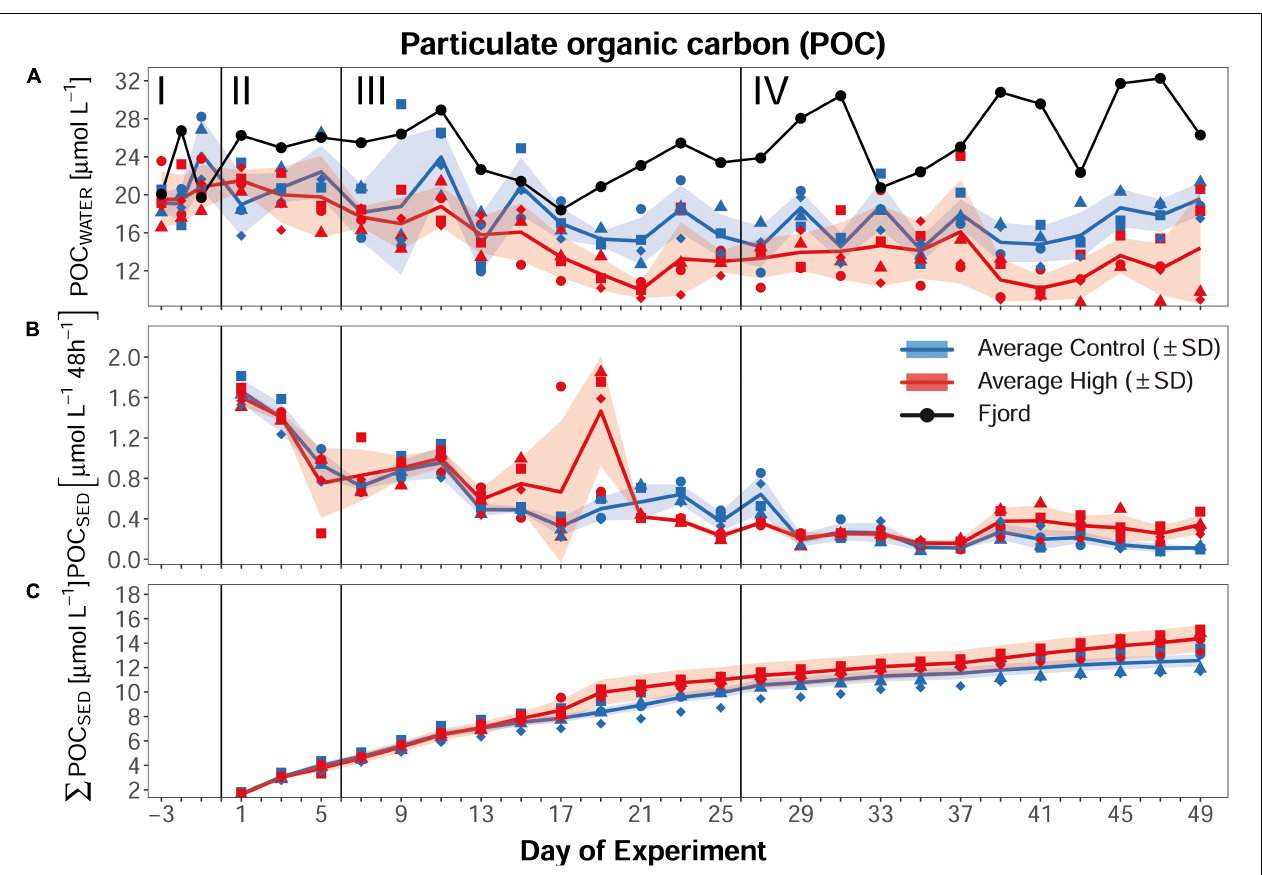
FIGURE 8 | Overview of particulate organic carbon (POC) concentrations and vertical fluxes. Development of (A) POC concentration within the water column (B) the 48 h POC flux collected in the sediment traps, and (C) the cumulative vertical POC flux over the course of the experiment. Lines, symbols, and colors are used as described in Figure 4 . Roman numerals label the different phases of the experiment separated by vertical lines (for description of phases see Table 2 ). Figure created with the ggplot2 package in RStudio (Rstudio Team, 2016; Wickham et al., 2016).